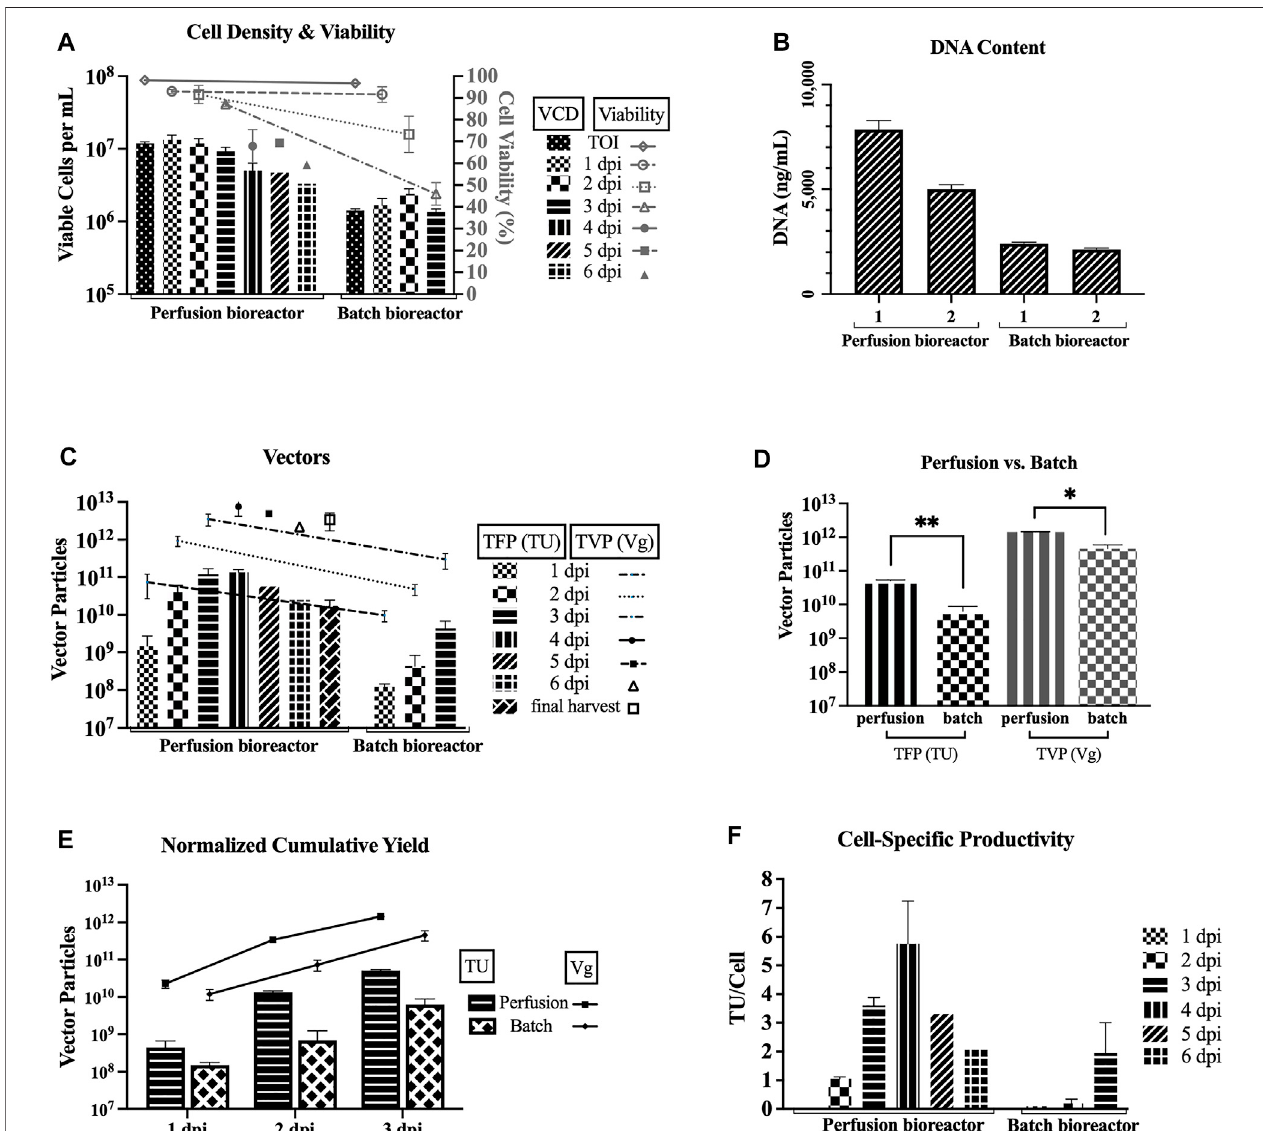
FIGURE3| ImprovedTFPandTVPwithTFDFperfusionbioreactors.TFDF=TangentialFlowDepthFiltration;VCD=viablecelldensity;TOI=timeofinduction;dpi =days post induction;TFP=total functionalparticles;TVP=total vectorparticles;TU=transducingunits; Vg=vectorgenome.1dpi,2dpi,and3dpi represent sample pools(e.g.,2dpiincludesLVsproducedfrom24to48 hpostinduction).Valuesareshownasmean+SD( n =2forperfusionruns, n =2forbioreactorruns). (A) VCDand cell viability data. (B) DNA content for the sample pool up to 3 dpi (i.e., includes LVs produced from 0 to 72 h post induction; values shown as mean +SD refer to serialdilutionsofthe sampleson theassay plate). (C) TFPand TVP data. (D) Statisticalanalysisusing anunpaired t -test – adjusted p -value forTFP between perfusion vs. batch runs is 0.0037 and adjusted p -value for TVP between perfusion vs. batch runs is 0.0104. (E) Cumulative yields normalized per 1 L of harvest (at 3dpi – perfusion runs:1.2×10 11 TFP,3.5×10 12 TVP;batchruns:4.4×10 9 TFP,3.0×10 11 TVP). (F) Cell-speci fi